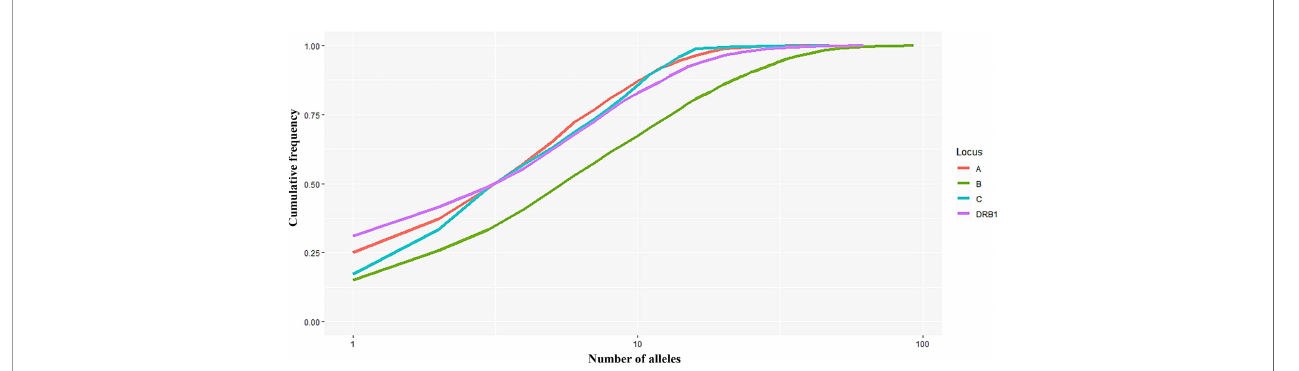
FIGURE 1 | Curves showing the cumulative frequency of alleles for each HLA locus (A, B, C, and DRB1). The number of alleles ( n ) on the x -axis is expressed on a logarithmic